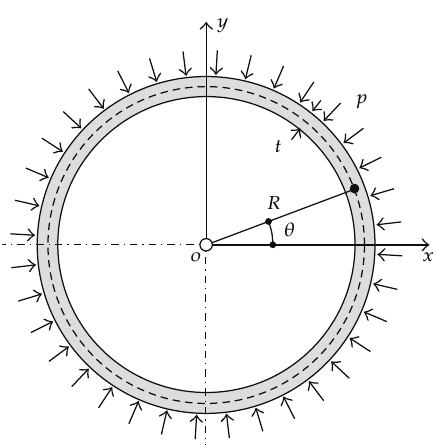
Figure 3: A ring under external